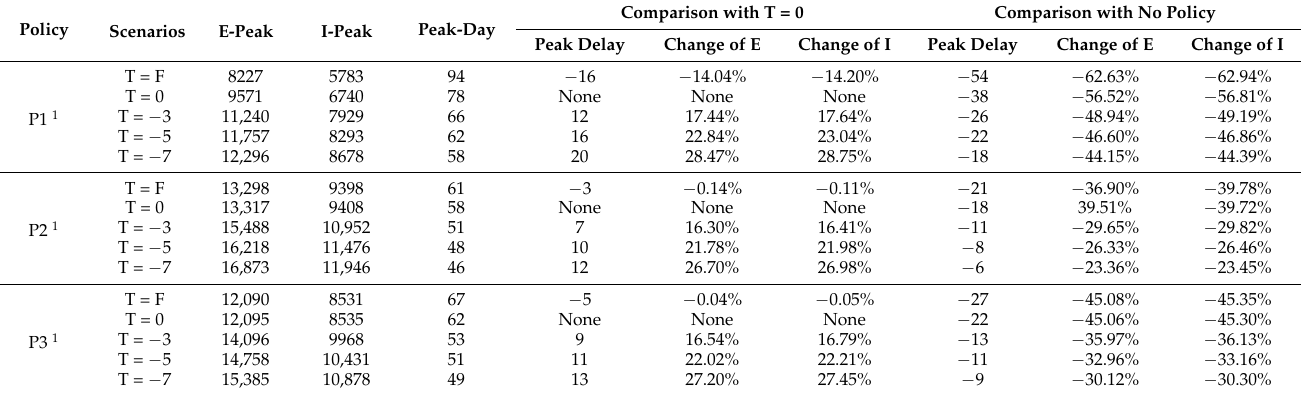
Table 7. Comparative analysis between epidemic trends under different policies.